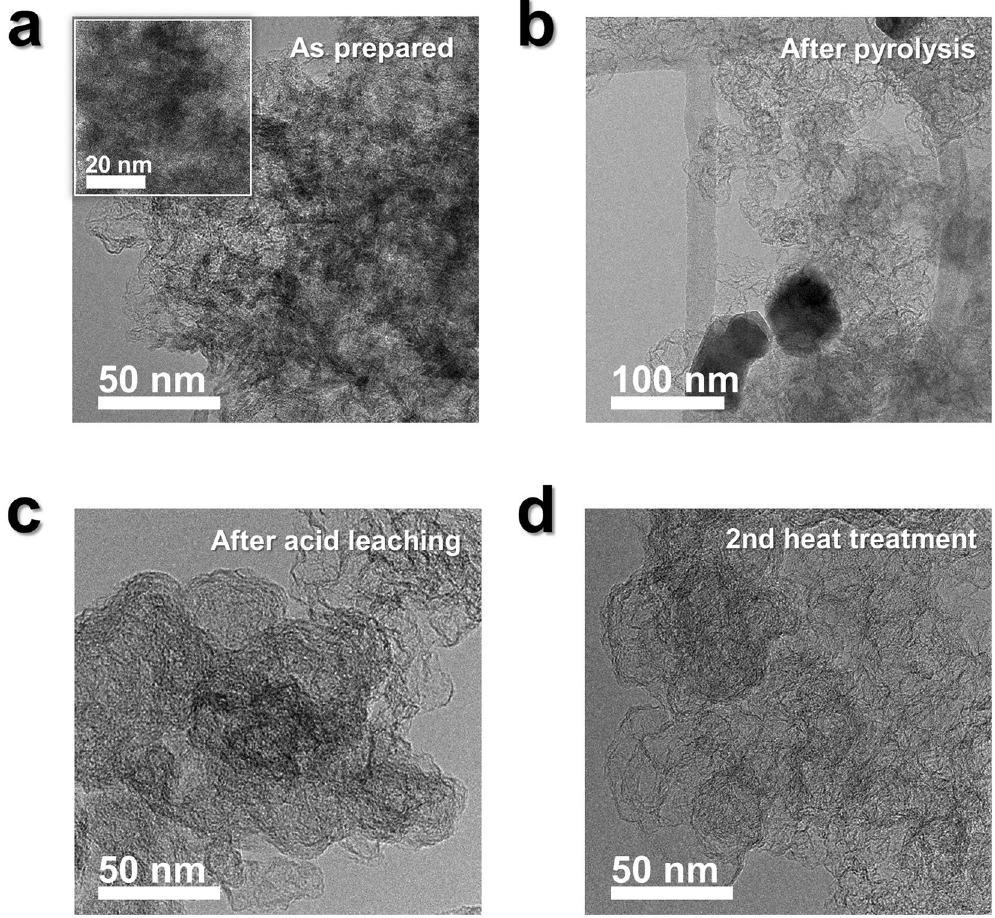
magnification image of as prepared Fe-PANI-K and scale bar is 20